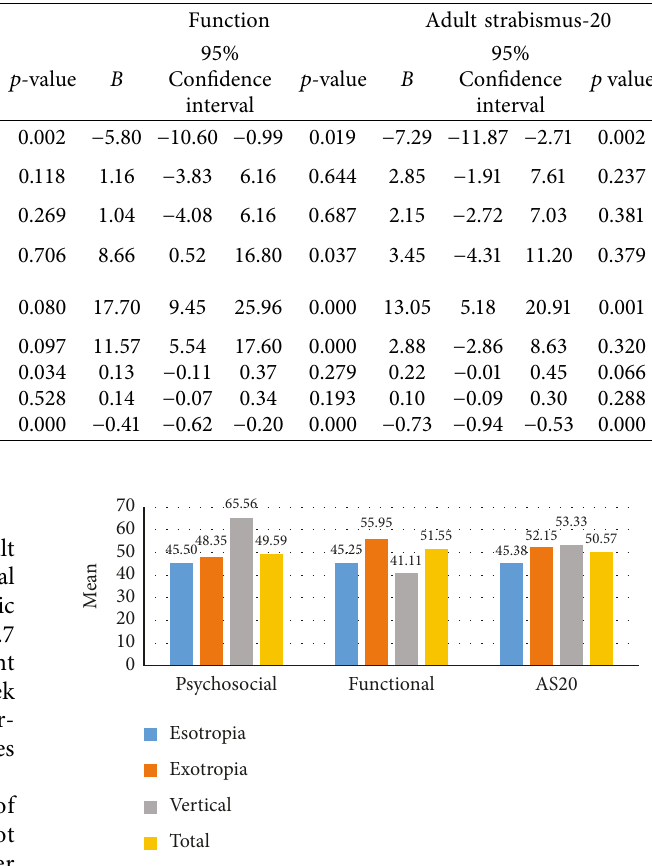
Figure 1: Types of deviation’ impact on total AS-20, psychosocial, and functional mean scores.